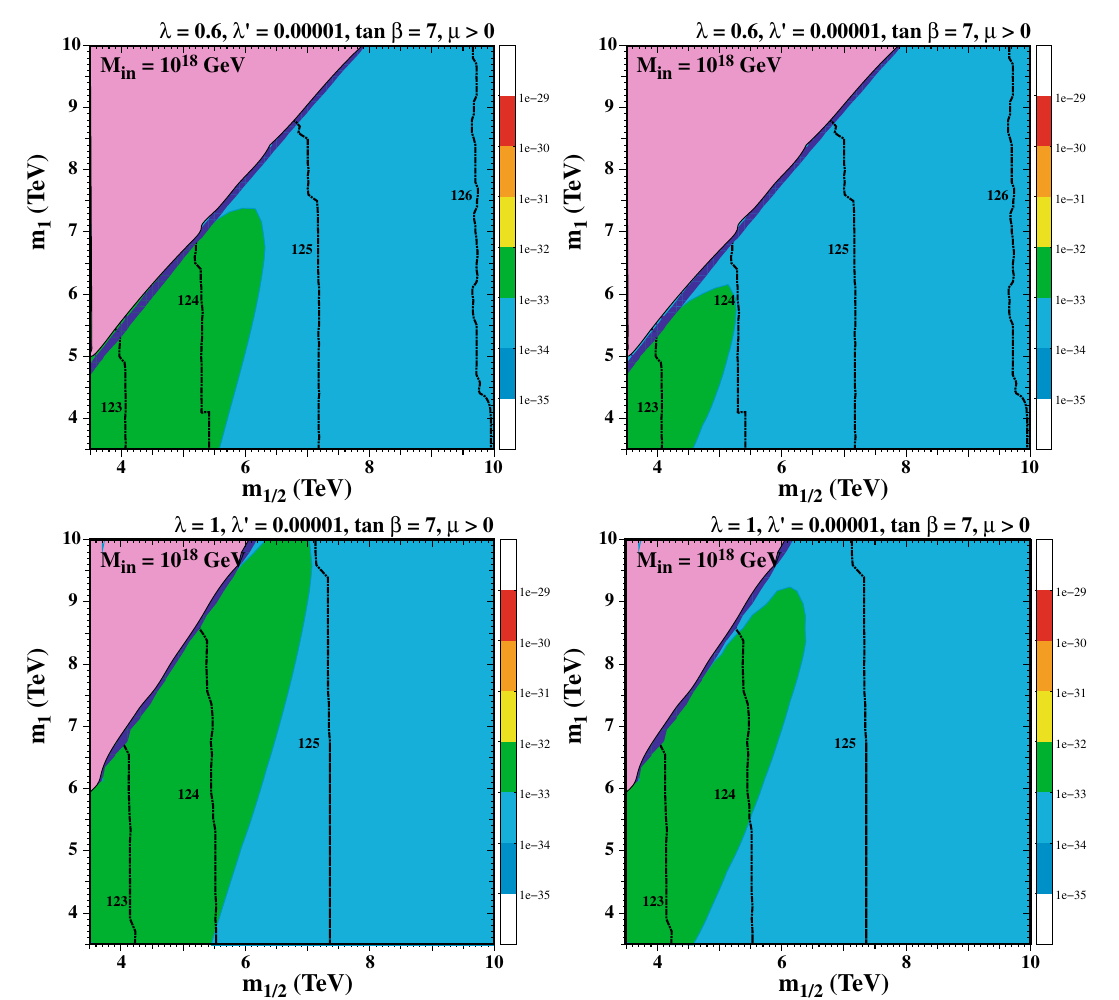
Fig. 9 As in Fig. 5, showing values of of the electron EDM for the choices A (left) and B (right) in model M3 with M in = 10 18 GeV, tan β = 7, λ (cid:8) = 0 . 00001 and λ = 0 . 6 (upper panels) or model M4